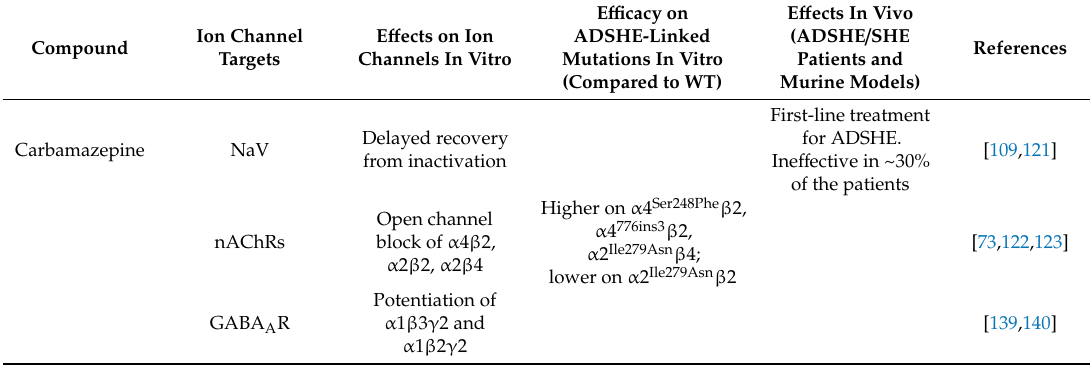
Table 2. E ff ects in vitro and in vivo of the antiepileptic drugs discussed in Section 5. Ion Channel E ff ects on Ion Compound Targets Channels In Vitro